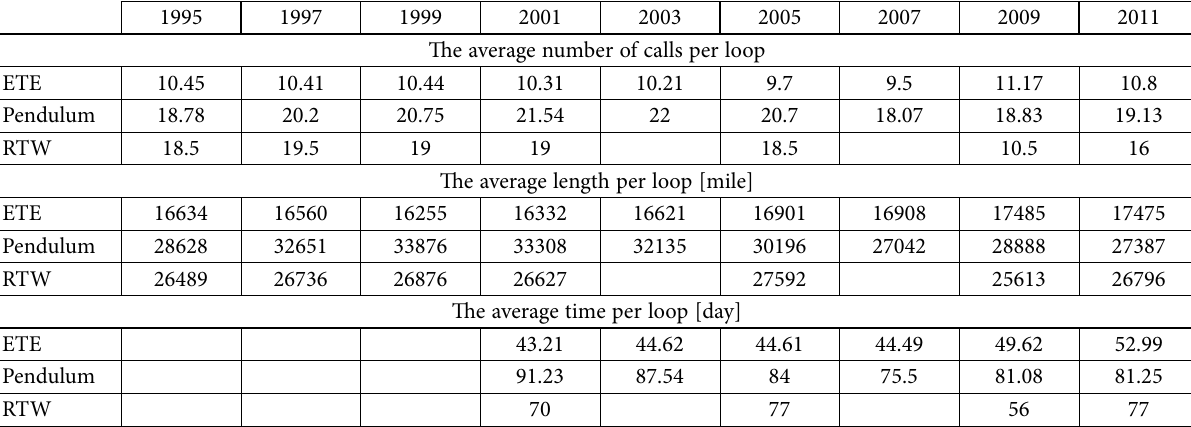
Table 8. Scale comparison between ETE, pendulum and RTW routes